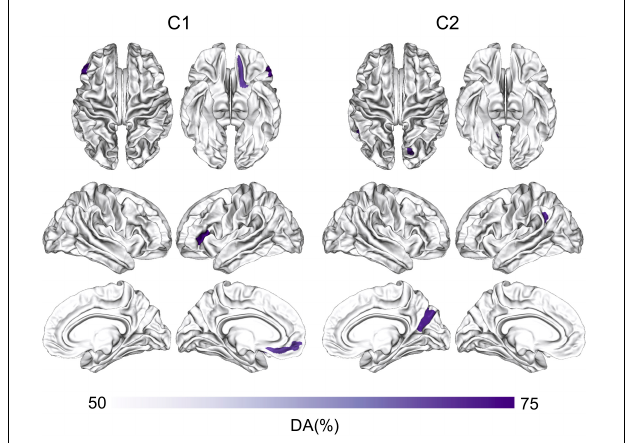
FIGURE 4 | ROI-based classification of SZ and controls using C1 and C2. Machine-learning classification of SZ patients and healthy controls using logistic regression and the features of C1 or C2 at the ROI-level. The ROI analysis was based on the Destrieux Atlas, p < 0.05, corrected for multiple comparisons. DA, decoding accuracy; SZ,